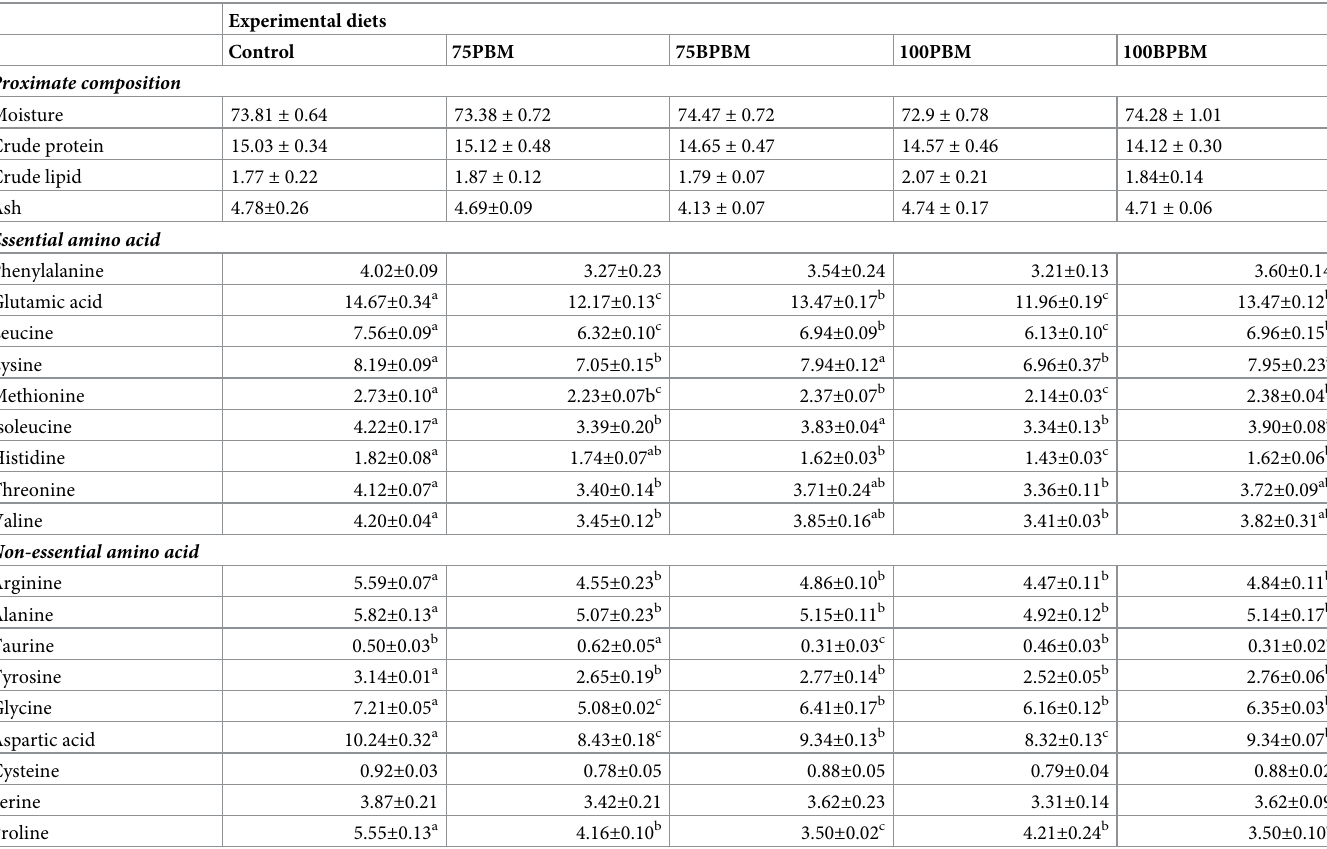
Table 5. Proximate composition (% wet weight basis) and amino acid profile (g/100g) of muscle tissue in juvenile barramundi at the end of feeding trial for 42 days.